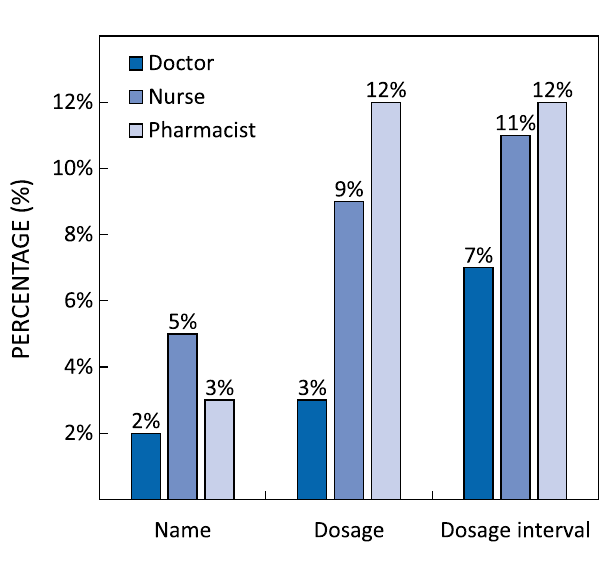
Figure 1: Percentage of errors per prescription. Table 1: Errors per abbreviation for the different health care workers